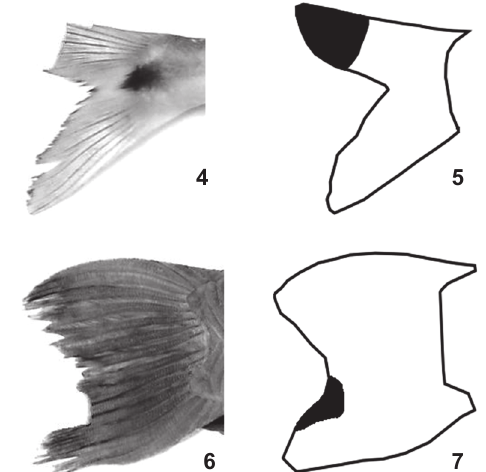
Figures 4-7. Schematic representation of the procedure to obtain caudal fin area lost by mutilation (area is detached in black). (4-5) example based on an individual of Acestrorhynchus lacustris , stan- dard length: 14.1 cm: (4) original caudal fin, (5) contour of esti- mated intact caudal fin; (6-7) example based on an individual of Hoplosternum littorale , standard length: 14.8 cm: (6) original cau- dal fin, (7) contour of estimated intact caudal